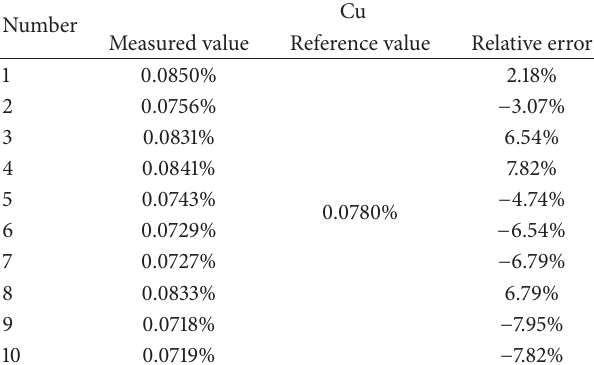
Table 7: Cu content of